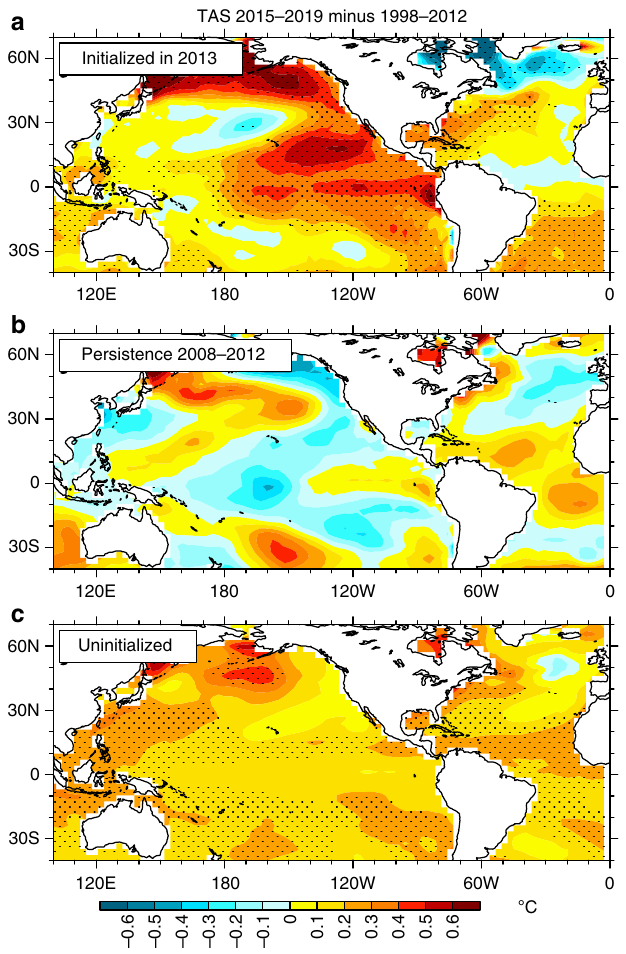
Figure 4 | Predicted patterns of surface temperature. ( a ) Global surface air temperature anomaly patterns ( (cid:2) C) for prediction initialized on 1 January